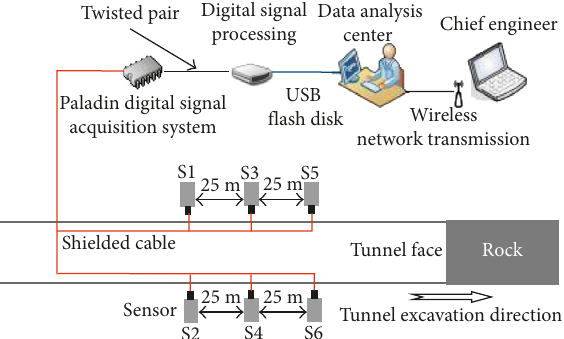
Figure 2: Complete schematic diagram of the sensor arrangement and the data acquisition, transmission, and processing in the microseismic monitoring system.